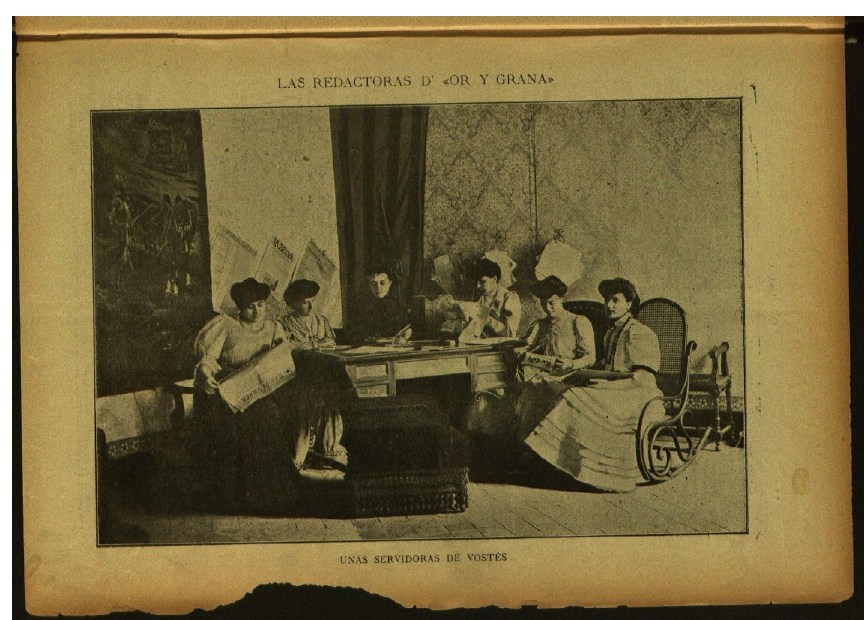
Fig. 1 The all-female editorial team of Or y Grana (6 October 1906). Arxiu de Revistes Catalanes